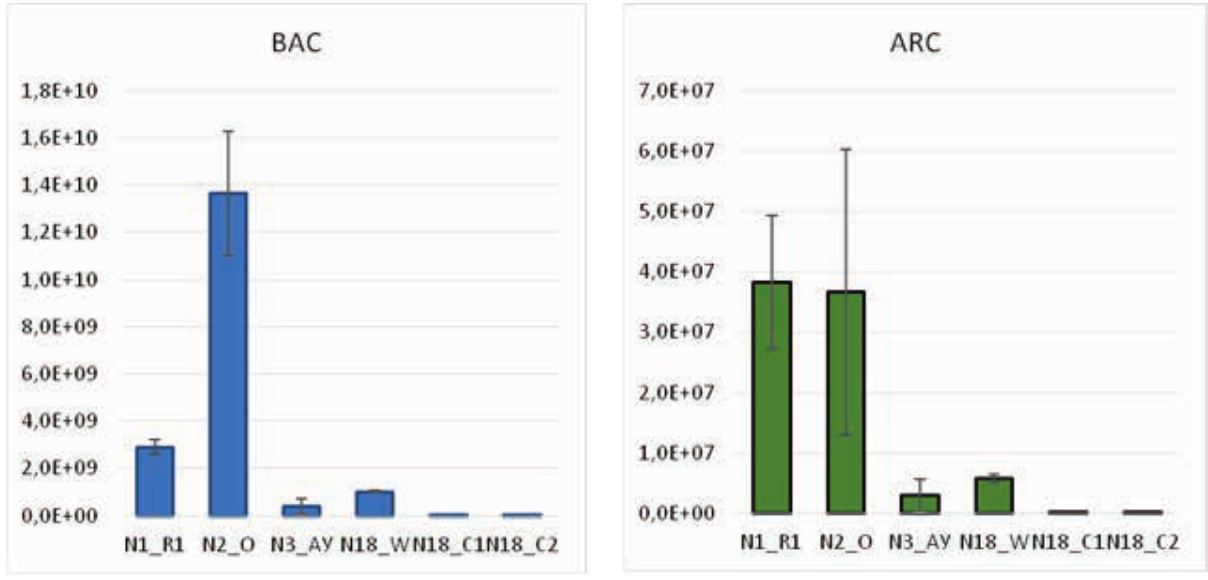
Figure 2: Quantity of bacterial (BAC) and archaeal (ARC) operons in studied soil samples, acquired by Real-time